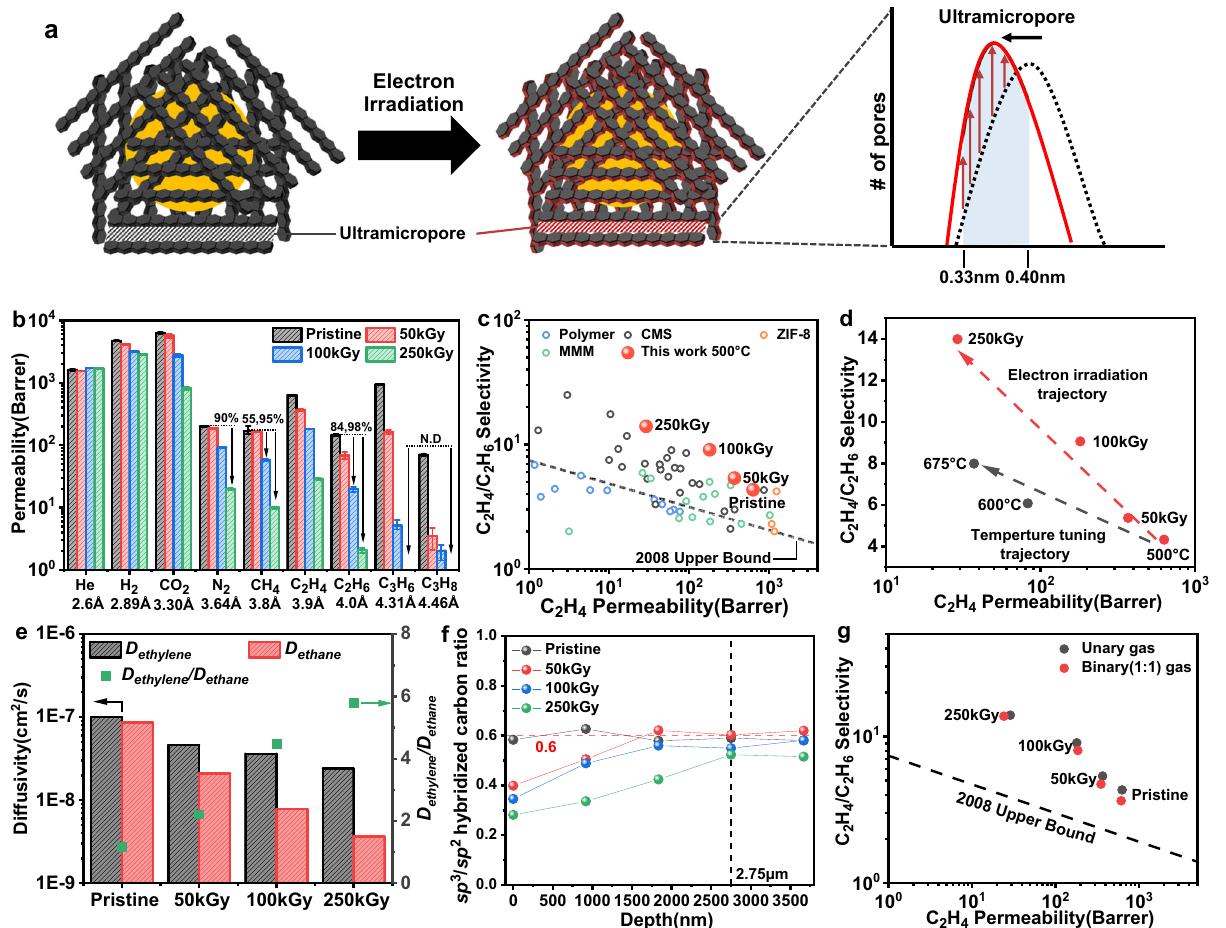
Fig. 3 | Gas permeation performancesand diffusionpropertiesoftheprepared CMSmembranes.a Schematicdescription ofturbostratic carbonstructurewith hypothetical ultramicropore size distribution change before and after electron irradiation. The red-shaded edge of the carbon strands imply oxygen- functionalization and pore compaction. b Permeation data of 500°C pristine and electron-irradiated CMS membranes for nine gases with respect to kinetic diameter. The black arrows show permeability reduction in electron-irradiated CMS(100and250kGy-CMS)comparedtothepristineone.C 3 gaspermeabilities in 250kGy-CMS were not determined due to measurement limit. (error bars indicate the standard deviation at three or four measurements) c C 2 H 4 /C 2 H 6